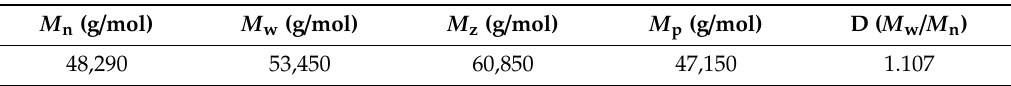
Figure 3. Molecular weight and its distribution of PI-OH. Table 1. The gel permeation chromatography (GPC) results of hydroxyl-terminated polyisoprene (PI-OH).